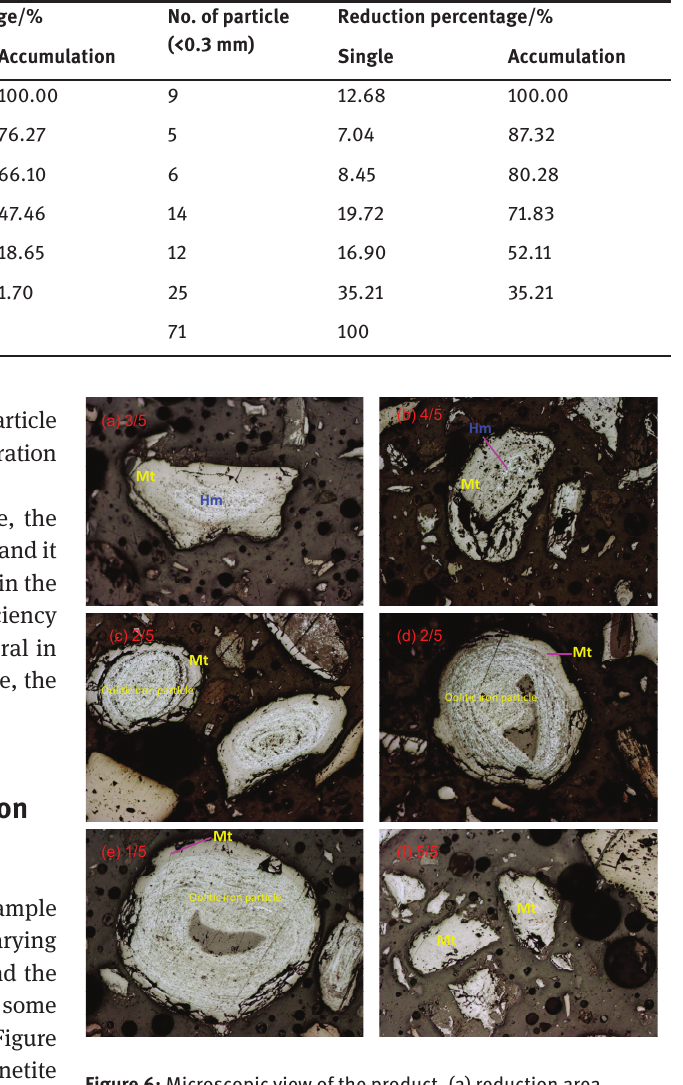
Figure 6: Microscopic view of the product, (a) reduction area with ratio 3/5, (f) fully reduction with 5/5 ( d =1.0~1.20 mm), after magnetic roasting at 800 o C for 60 min. Mt denotes Magnetite, Hm is Hematite.